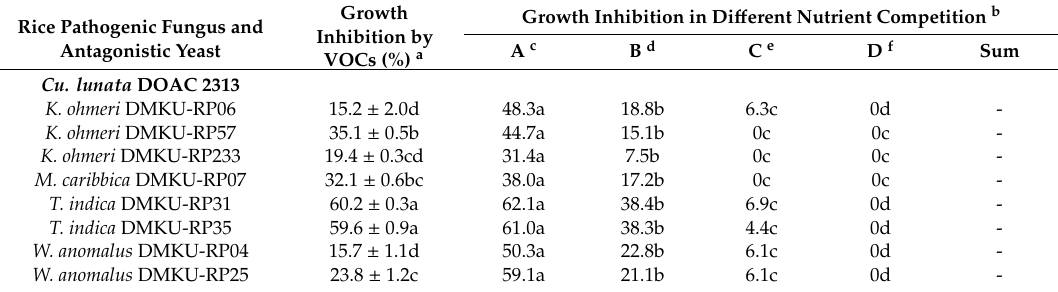
Table 5. Production of antifungal volatile organic compounds and competition of nutrients of the antagonistic yeasts against rice pathogenic